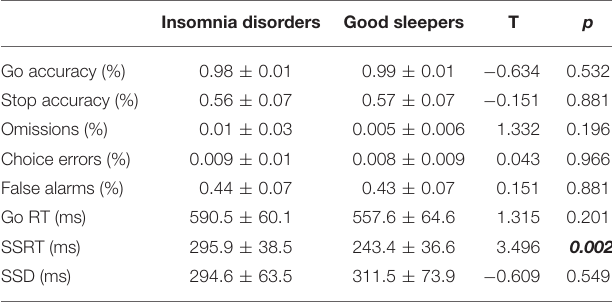
TABLE 2 | Descriptive statistic of the stop-signal